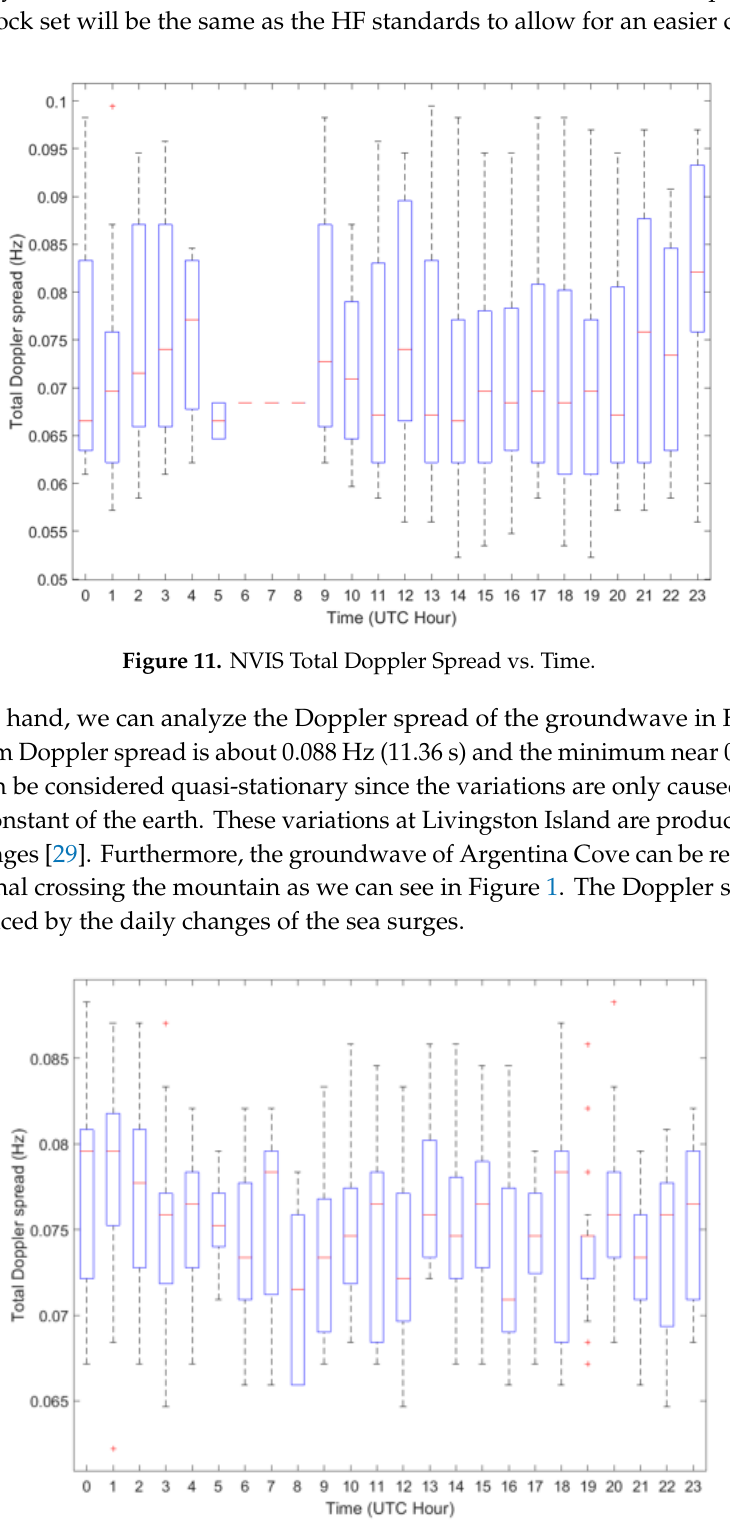
Figure 12. Groundwave Total Doppler Spread vs Time.